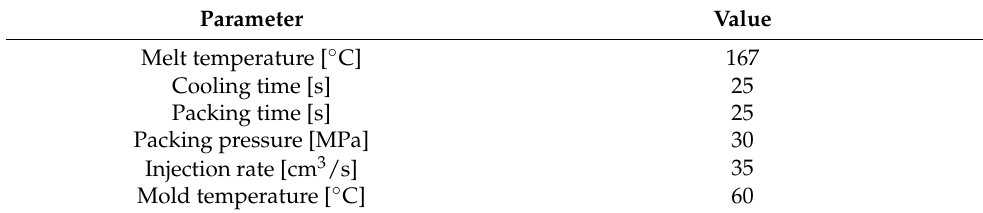
Table 5. The processing parameters of samples for uniaxial tensile testing.